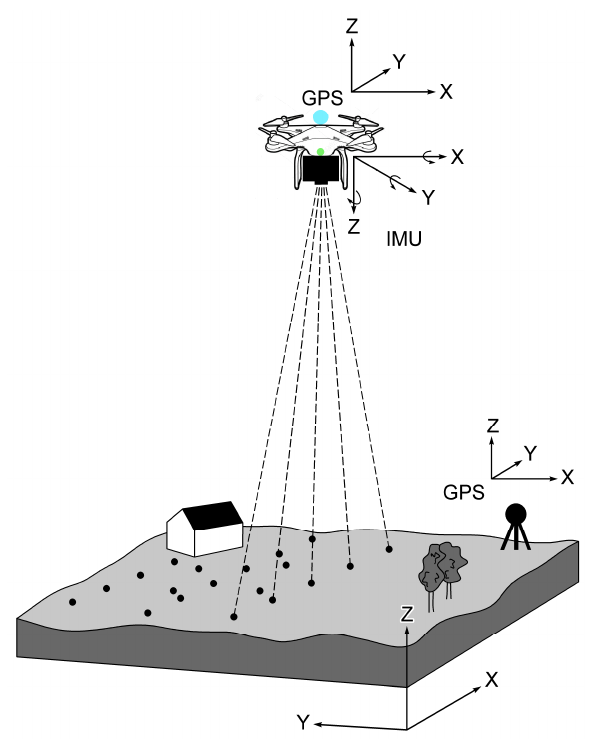
Figure 1. The unmanned aerial vehicle (UAV) light detection and ranging (LiDAR) measurement principle (from Wikipedia Commons, file licensed under the Creative Commons Attribution-Share Alike 3.0 Unported license).